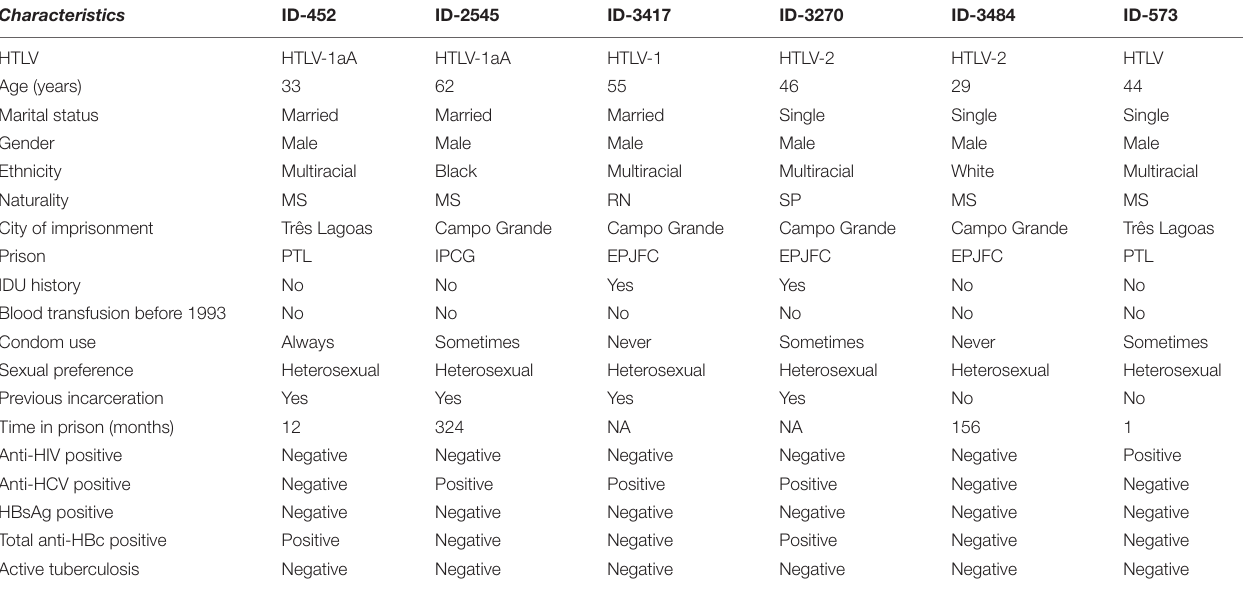
TABLE 2 | Sociodemographic and risk behavior characteristics of the six anti-HTLV infected prisoners of the cross-sectional study.